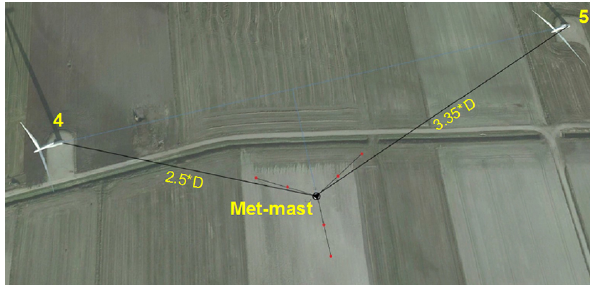
Figure 2. Relative position between reference wind turbine 4, met mast and turbine